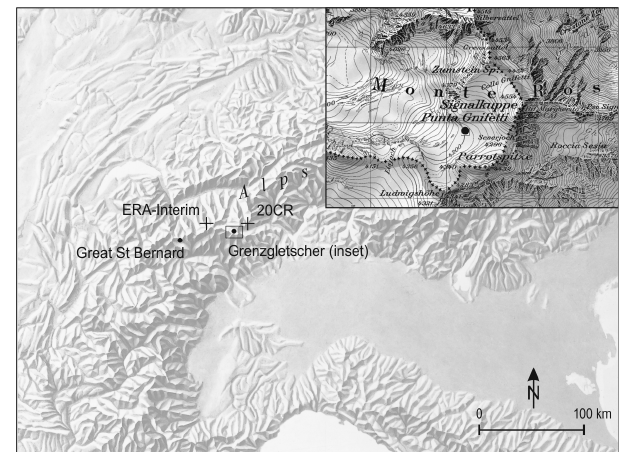
Fig. 1. Map of the study site and the locations of Grenzgletscher and Great St Bernard. The inset shows the drilling location of the Grenzgletscher ice core. Crosses show the locations of the grid points from Twentieth Century Reanalysis (20CR) and ERA- Interim. Printed with permission of the Schweizerische Konferenz der Kantonalen Erziehungsdirektoren (relief) and swisstopo